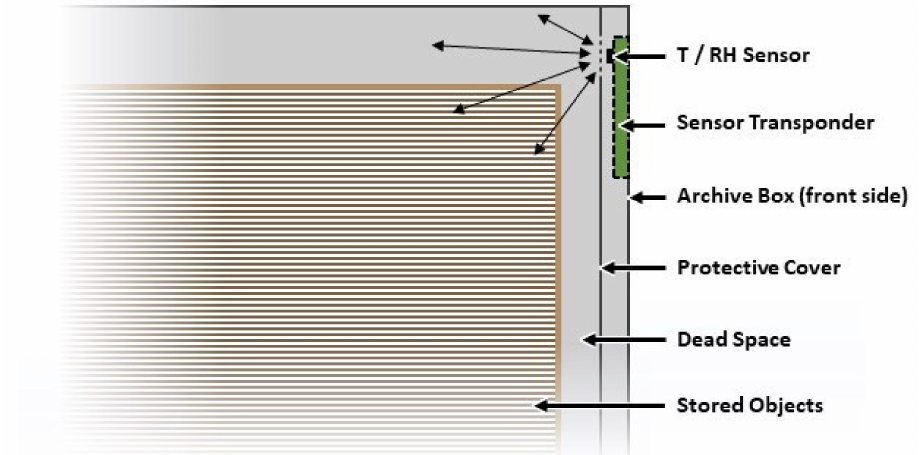
Figure 5. Schematic illustration of a packed archive box with integrated NFC sensor, which is exposed to a maximum of the interior atmosphere surrounding the artifact (indicated by